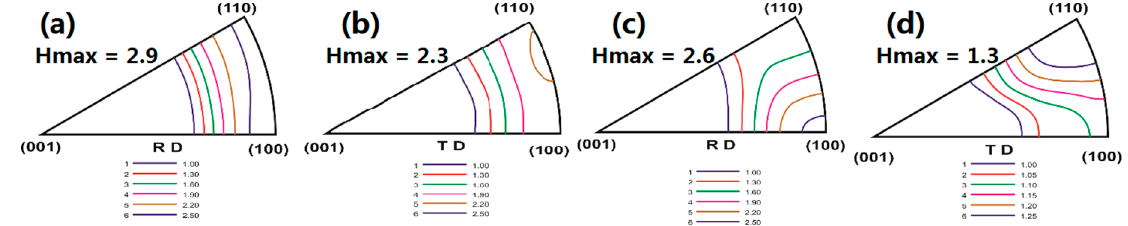
Figure 6. Inverse pole figures of alloys: ( a ) Z1 in RD; ( b ) Z1 in TD; ( c ) ZN10 in RD; ( d ) ZN10 in TD.